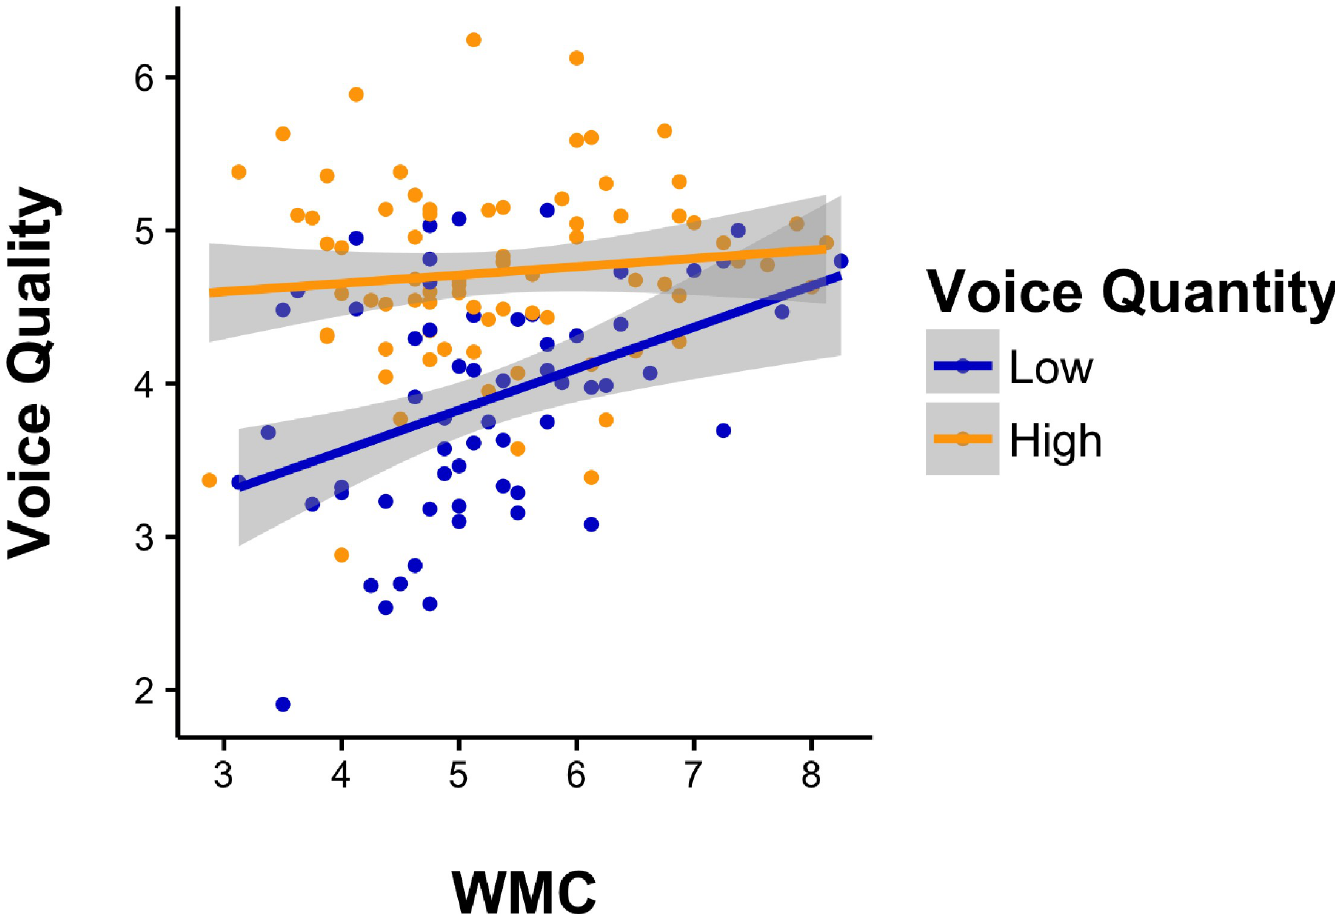
Fig 3. Interaction WMC � voice quantity on voice quality study